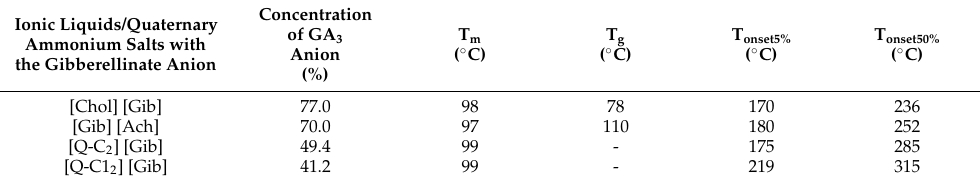
Figure 1. Leaves of Limonium latifolium , Heuchera hybrida ‘Chocolate Ruffles’, and Hemerocallis × hybrida ‘Agata’ after conditioning. Table 1. Ionic liquids and quaternary ammonium salts with the gibberellate anion. T m , melting point; T g , glass transition temperature; T onset5% , decomposition temperature of 5% sample; T onset50% , decomposition temperature of 50% sample.